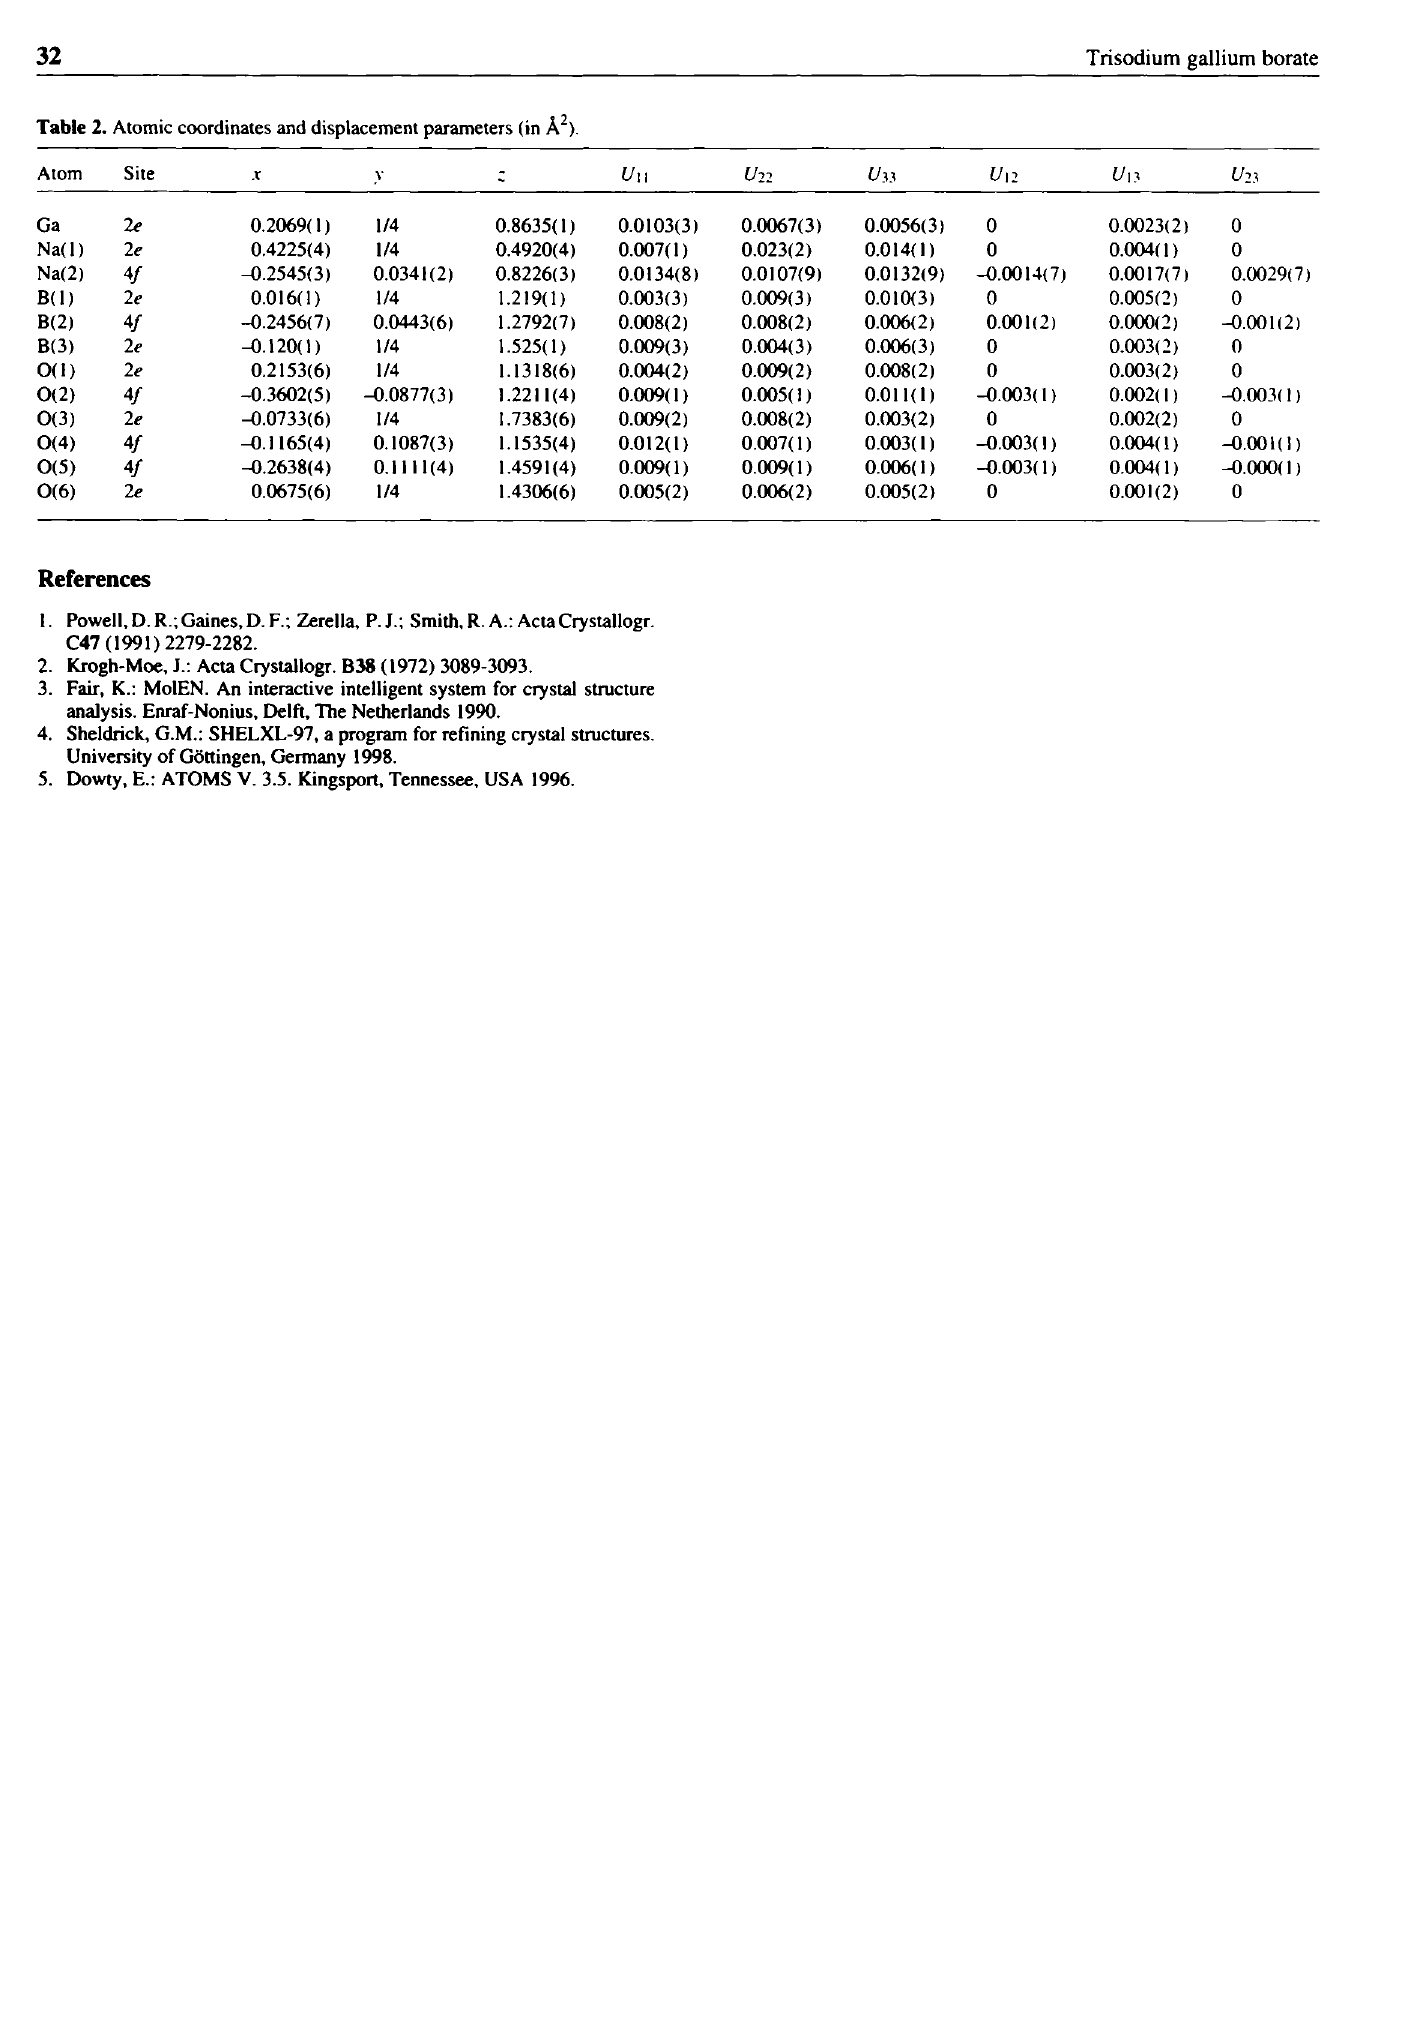
Table 2. Atomic coordinates and displacement parameters (in Ä 2